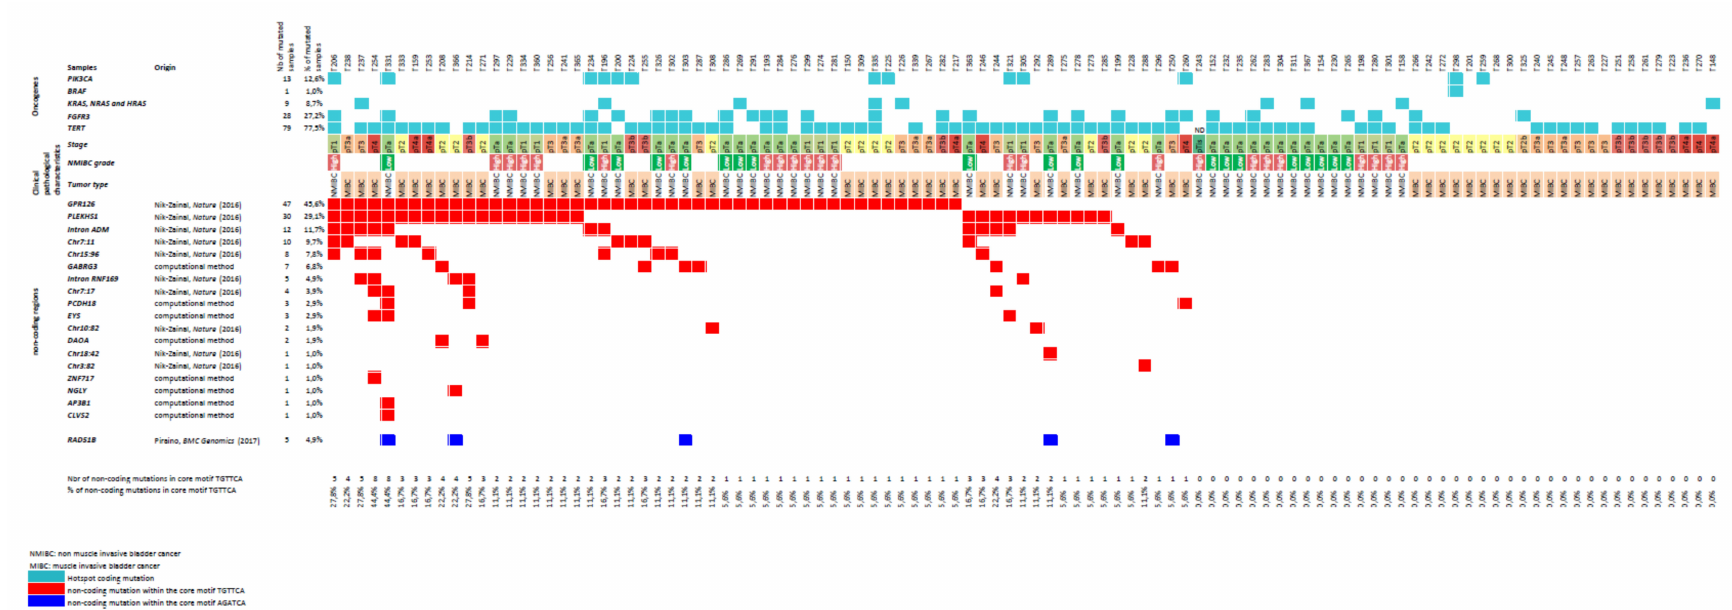
Figure 1. Non-coding mutation landscape, and clinical and biological characteristics of the bladder cancer